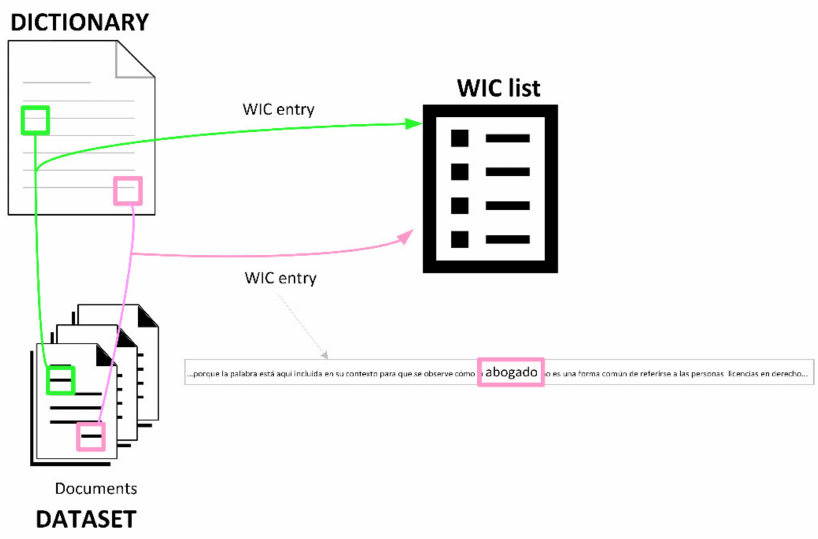
Figure 9. Generation of the word in context